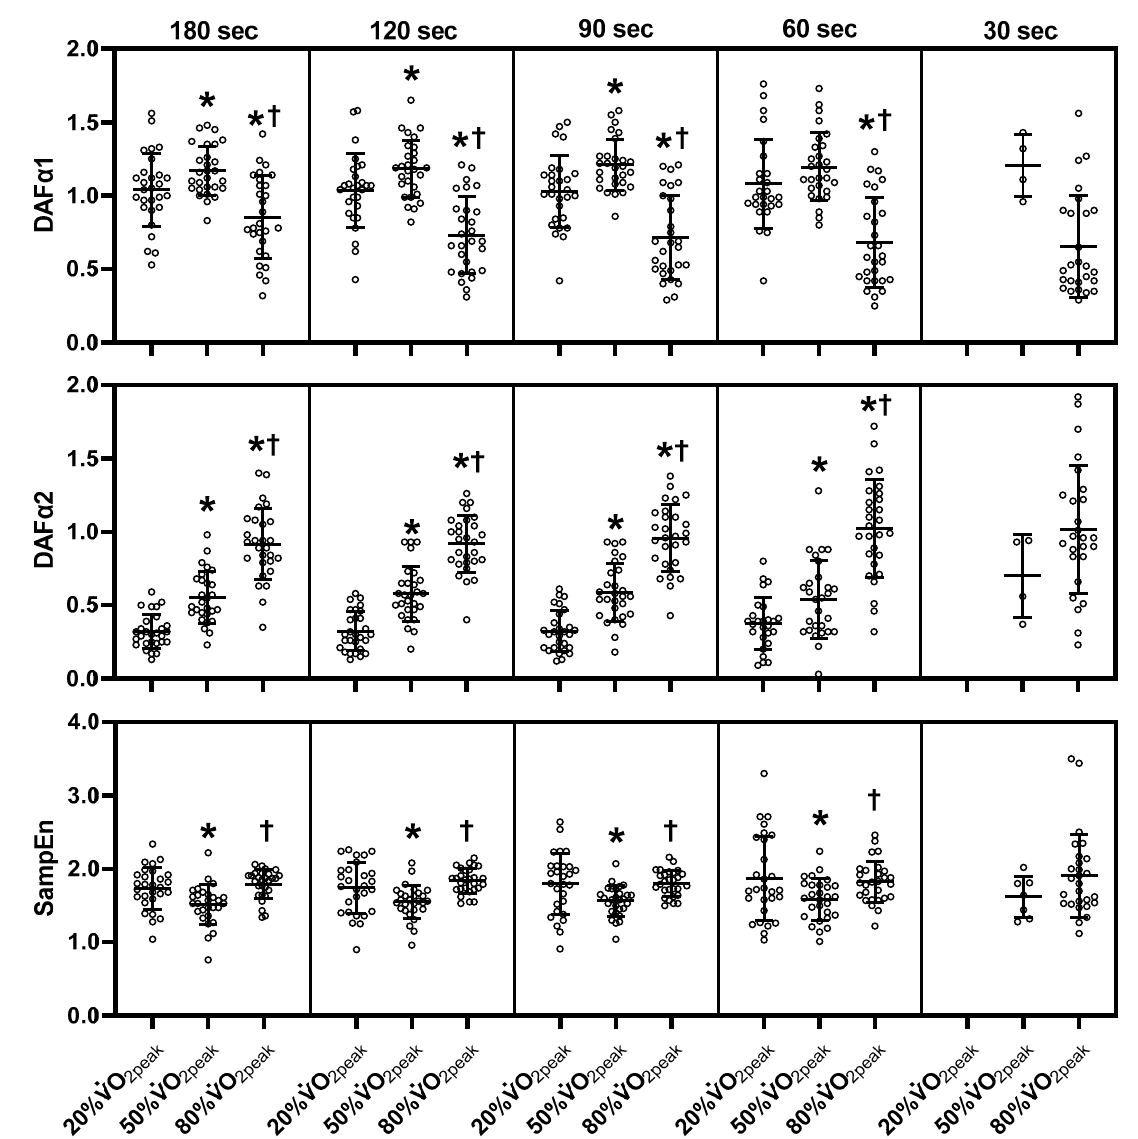
Figure 4. Changes of each ultra-short-term segment of non-linear HRV parameters during exer- cise. DFA, detrended fluctuation analysis; SampEn, sample entropy; log, logarithmic; sec, seconds; VO 2peak , peak oxygen uptake. The middle line indicates the mean value. The top and bottom lines indicate the SD. The white plots indicate the individual data of participants. Note that there is missing data (see the Materials and Methods section). *, p < 0.05 vs. 20% V O 2peak .